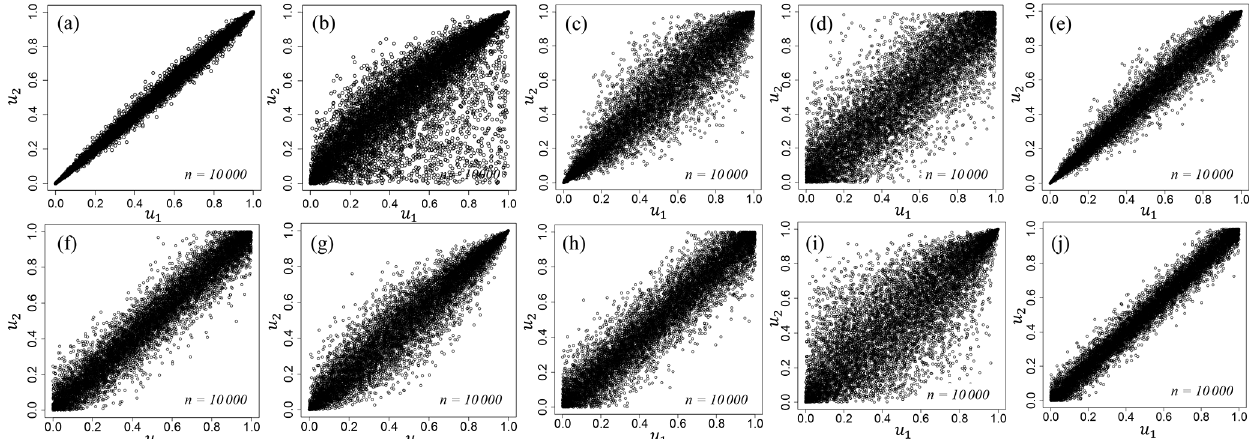
Figure 12. Estimated optimal copulas distributed on [0, 1] 2 with 10000 trials. (a) Rotated Gumbel copula for source 1, (b) asymmetric Gumbel copula for source 2, (c) rotated Gumbel copula for source 3, (d) Frank copula for source 4, (e) rotated Gumbel copula for source 5, (f) Frank copula for source 6, (g) Gumbel copula for source 7, (h) Frank copula for source 8, (i) Gumbel copula for source 9, and (j) Frank copula for source 10.